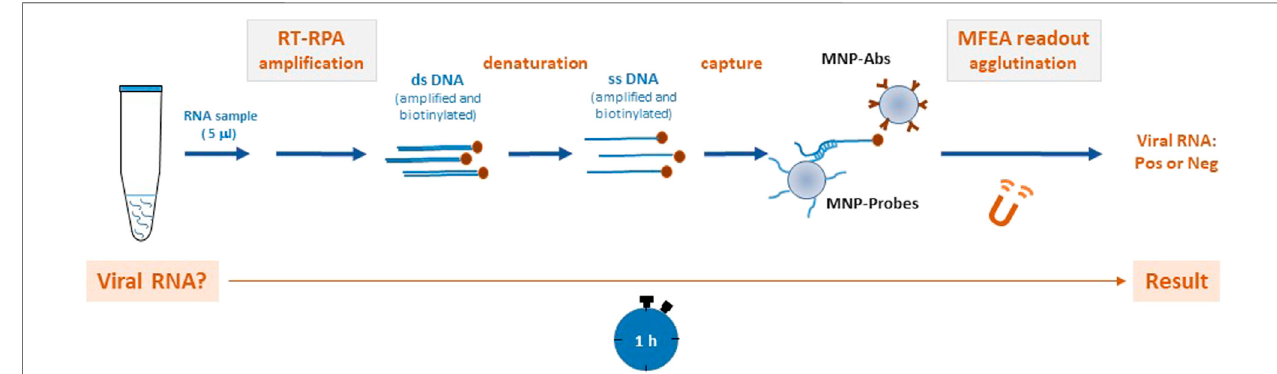
FIGURE 1 | Method for the rapid molecular detection of the dengue virus (DENV) based on reverse transcription recombinase polymerase ampli fi cation (RT-RPA) combined with a magnetic fi eld-enhanced agglutination (MFEA) readout DENV RNA is ampli fi ed using the RT-RPA method. After a denaturation step, the biotinylated DENV products are captured between magnetic nanoparticles (MNPs) that have been grafted with speci fi c anti-biotin antibodies (MNP-Abs) and DENV tetrathiolated DNA probes (MNP-Probes). MFEA accelerates the capture of the targets by a fast chaining process.